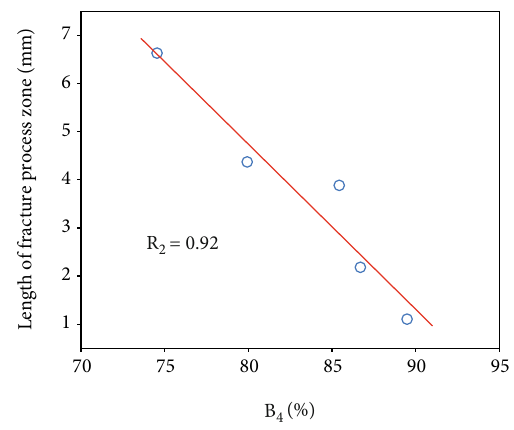
Figure 12: The relationship between B fracture process zone in Lucaogou